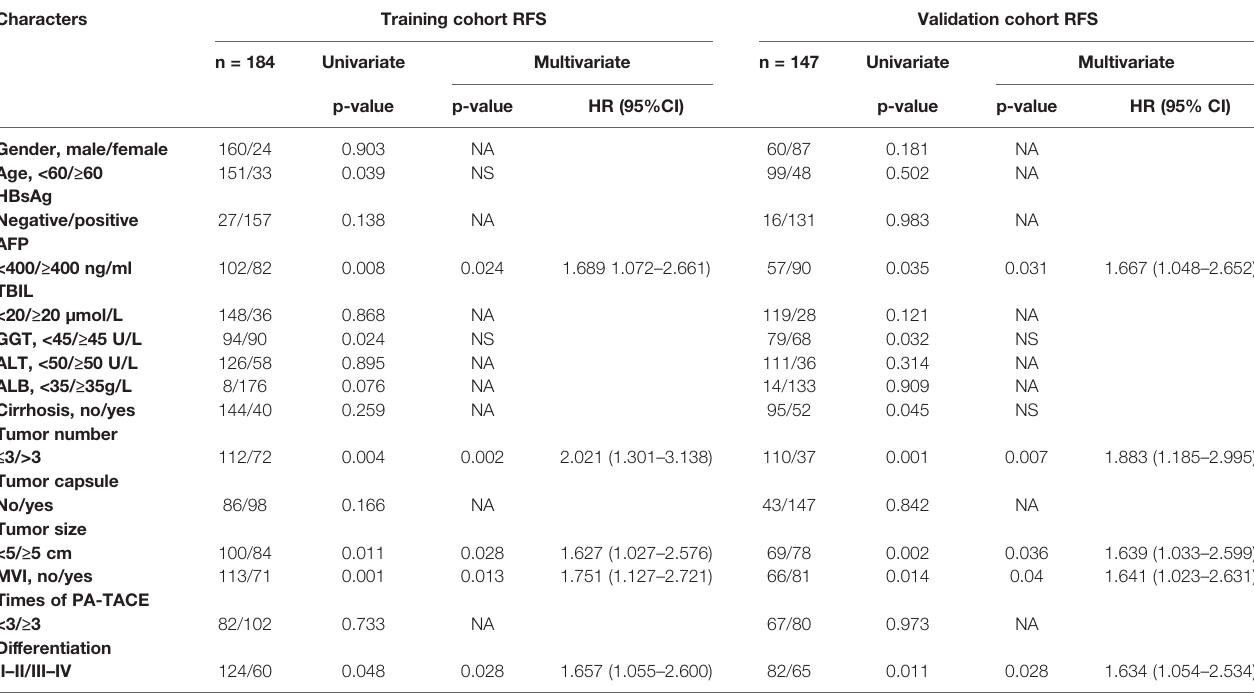
TABLE 3 | Univariate and multivariate analyses of RFS in training and validation cohort HCC patients underwent PA-TACE.